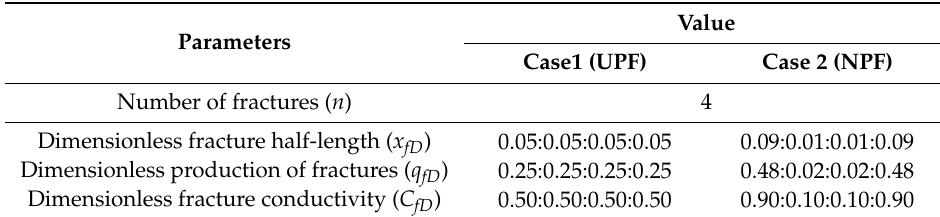
Table 2. The basic parameters of hydraulic fractures.